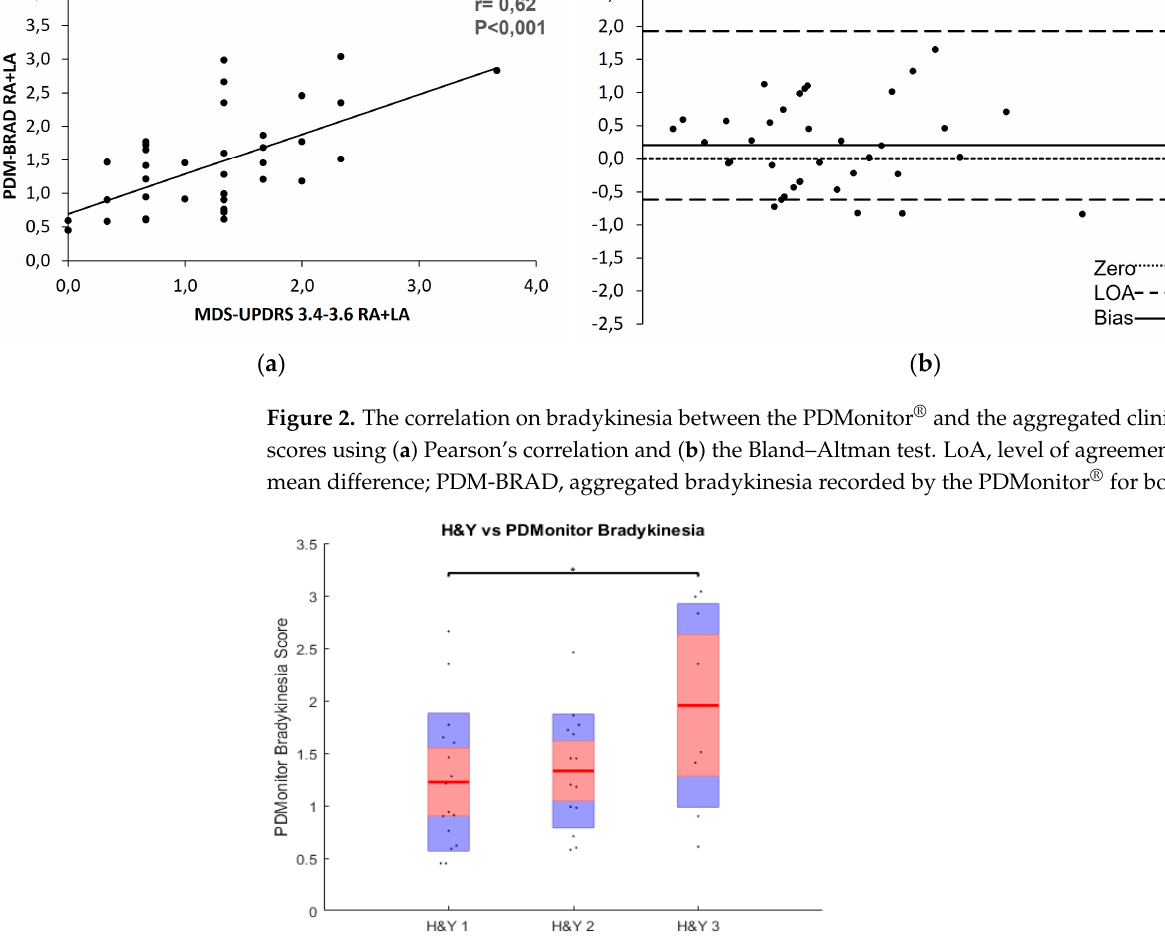
Figure 3. PDMonitor ® bradykinesia measures at different disease stages (H&Y 1–3).